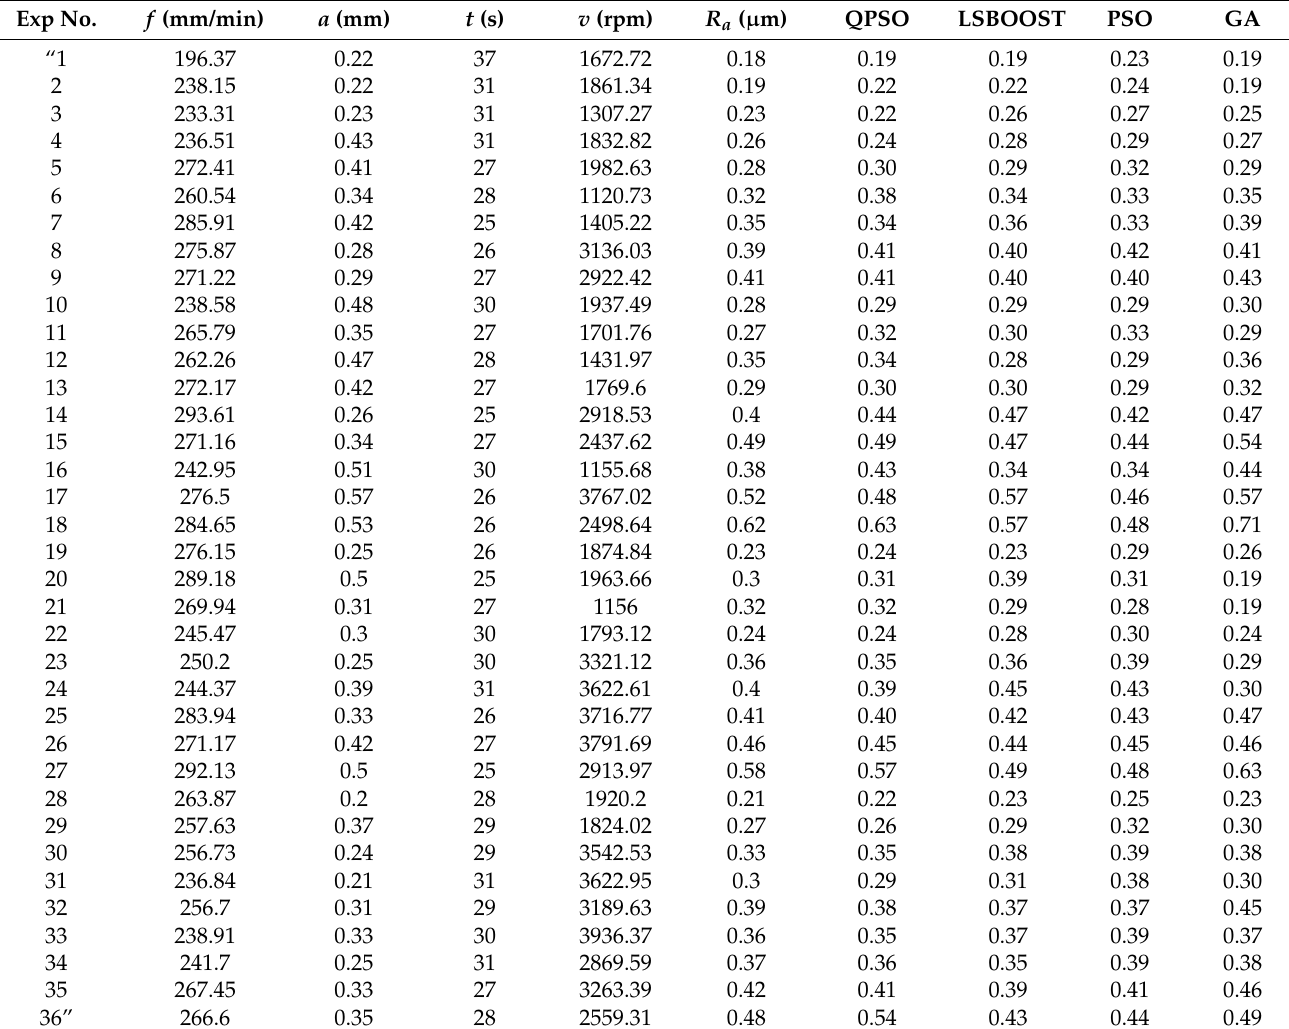
Table 6. Simulation results of QPSO, LSBoost, PSO and GA algorithms for the prediction of surface roughness values of a face milling machine.